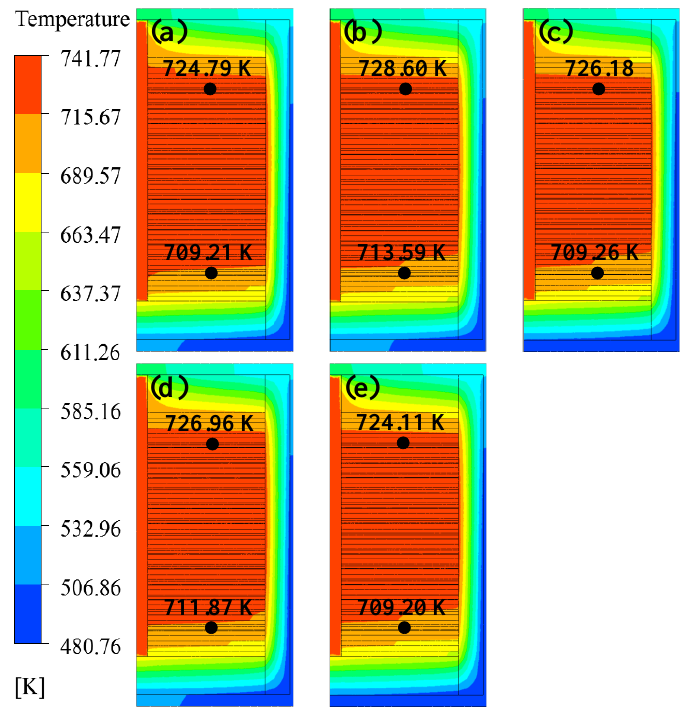
Figure 5. Temperature contours of the thermal battery module for ( a ) Δ d a = 0, Δ d b = 0; ( b ) Δ d a = 0, Δ d b = 0.24 mm; ( c ) Δ d a = 0, Δ d b = 0.36 mm; ( d ) Δ d a = 0.12 mm, Δ d b = 0; ( e ) Δ d a = 0.24 mm, Δ d b = 0 at t = 1250 s.